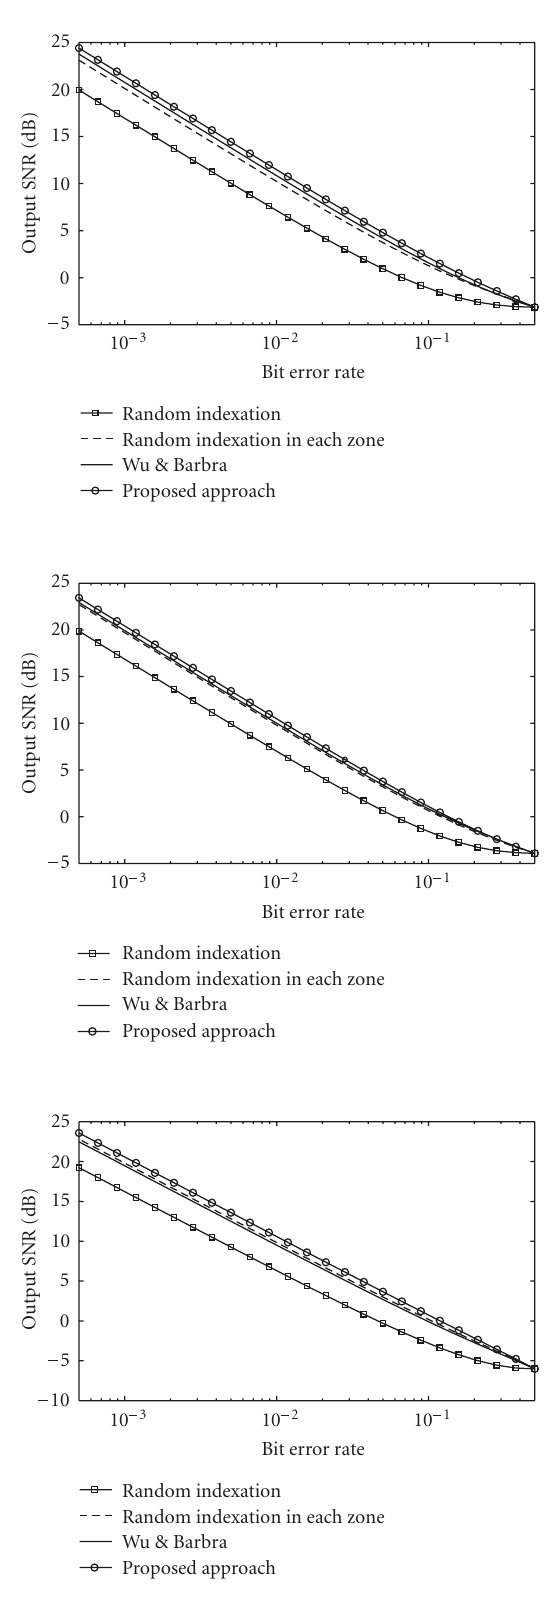
Figure 8: Output SNR yielded by various indexation schemes on two 256-vector codebooks (up and middle) and a 64-vector code- book